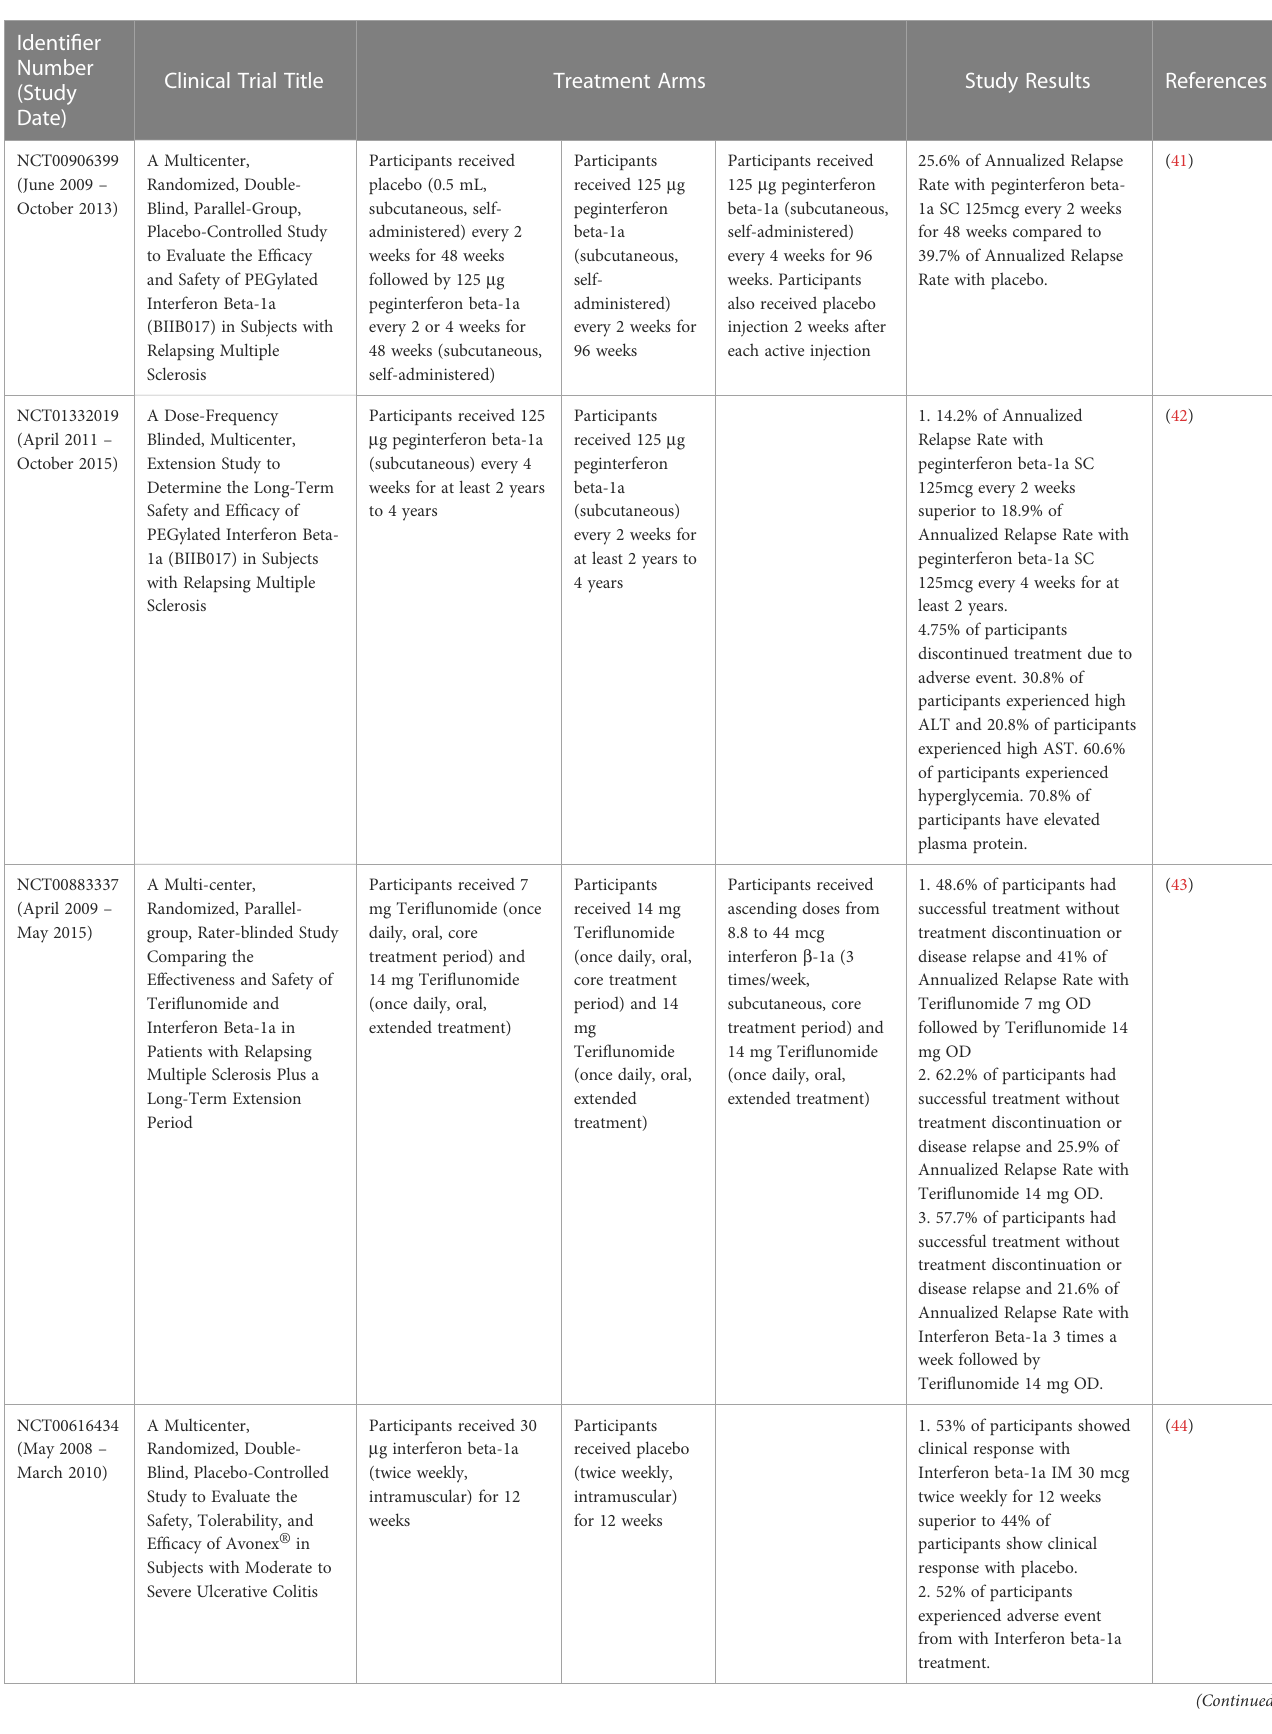
TABLE 2 Clinical trials of IFN- b and their